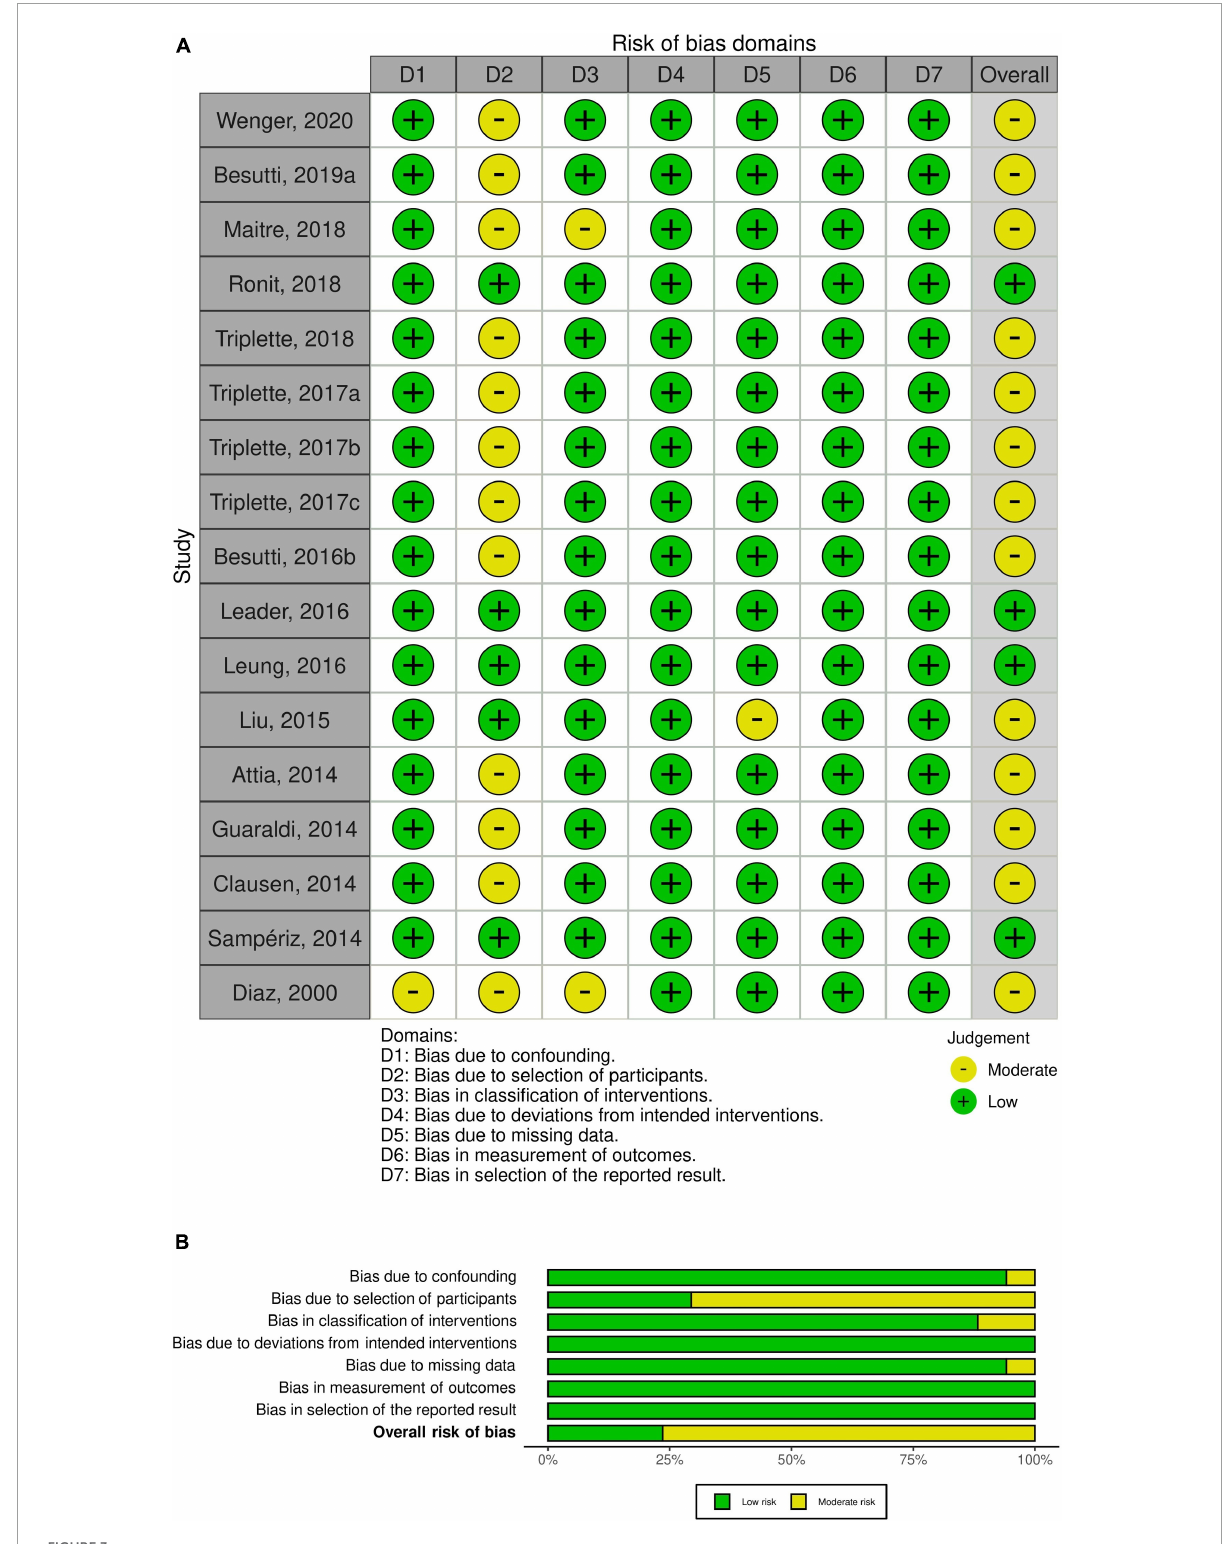
FIGURE3 Risk of bias for the included studies. (A) Traffic light plots; (B) weighted bar plots for non–randomized clinical trial. The overall risk of bias was low in 4 of 17 studies and moderate in 13